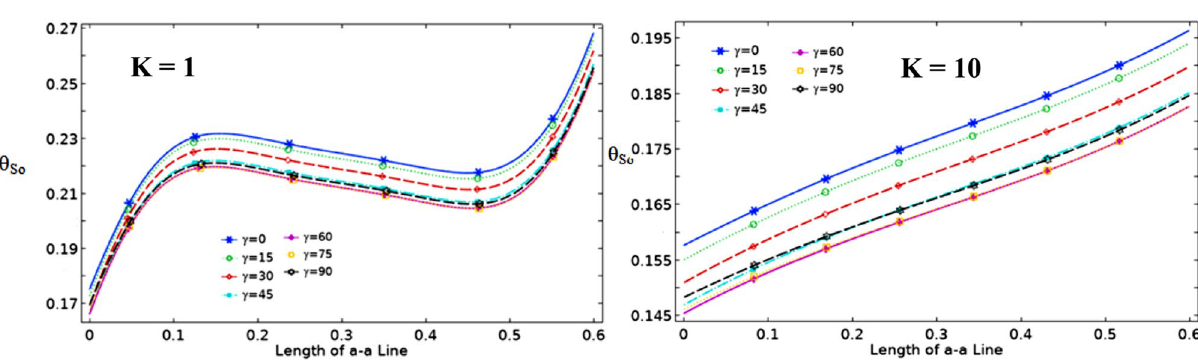
Figure 10. Dimensionless temperature along line a-a for different angles of magnetic field at Ra = 10 6 , Ha = 60, = 0.05, Ω = 500, and λ = ϕ